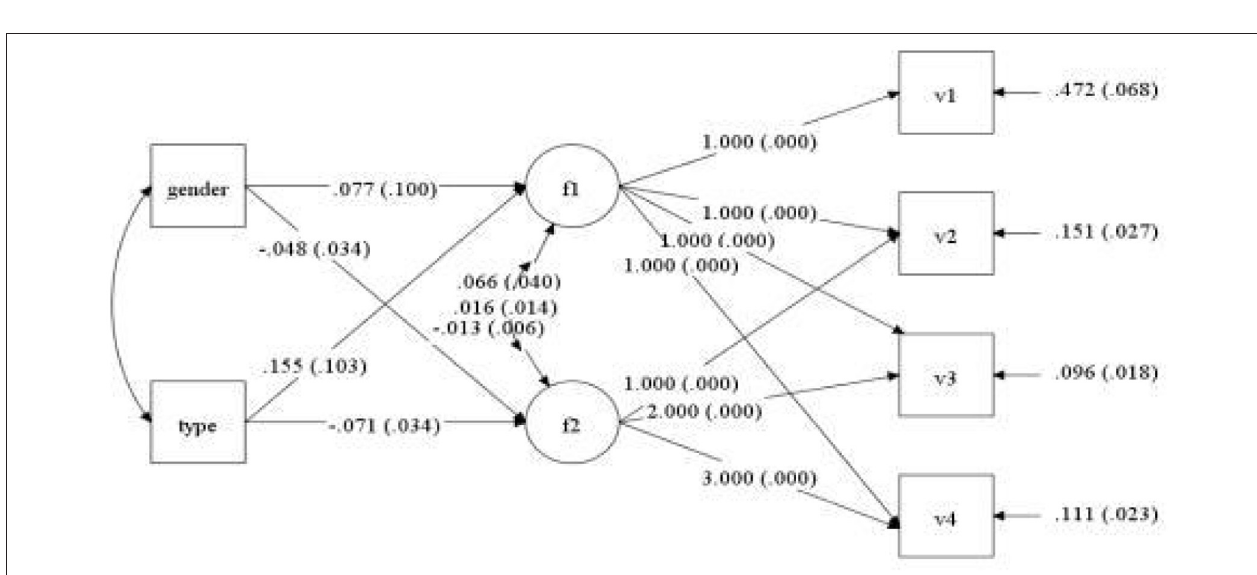
FIGURE 3 | Path of latent variable growth curve model of mental health status of medical staff.